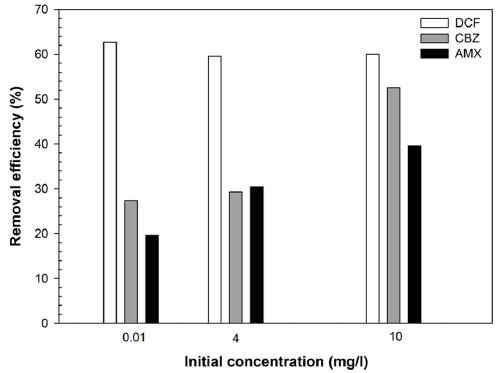
Figure 4. Effects of initial concentration on the removal of pharmaceuticals by electrochemical processes (conditions: j = 0.5 mA/cm 2 , HRT = 19 h).